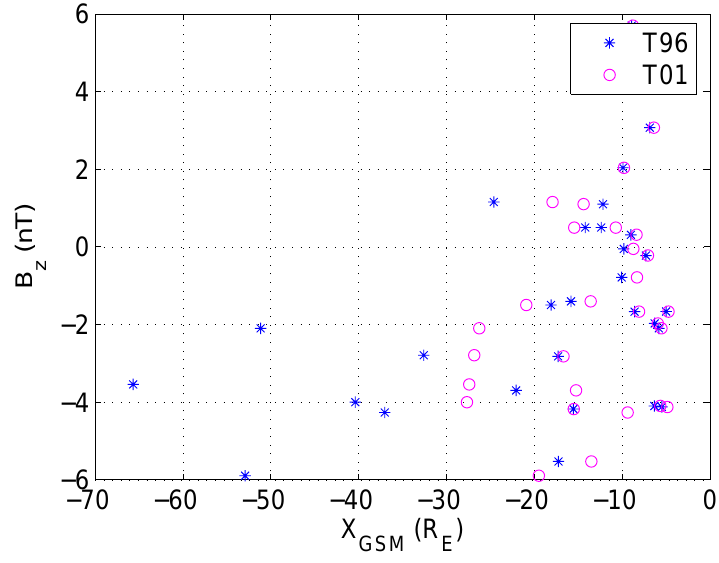
Fig. 9. Dependence of onset location with southward component of interplanetary magnetic field.